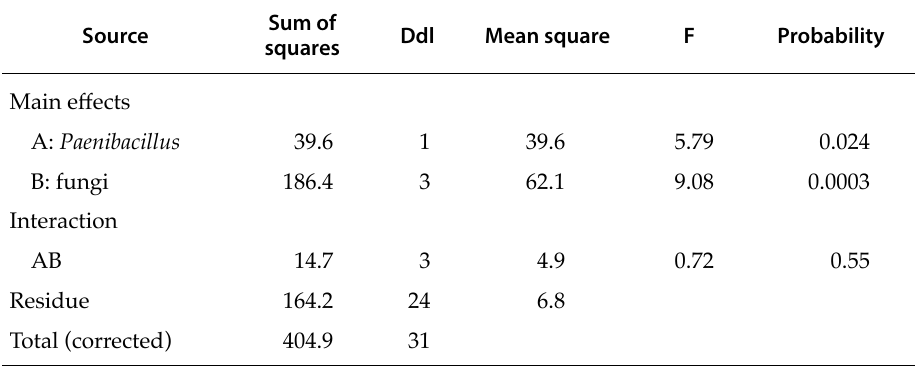
Total (corrected)